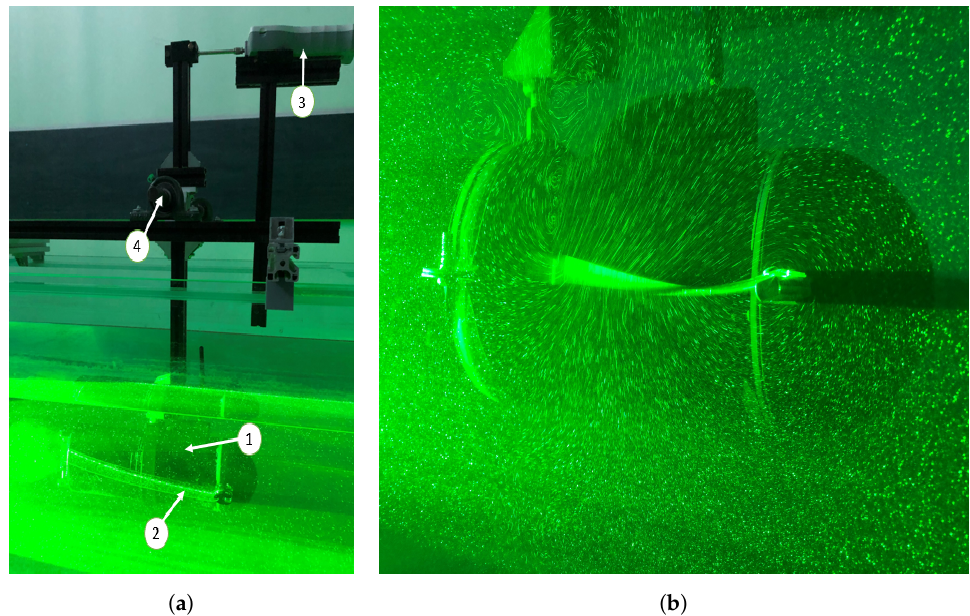
Figure 2. The laboratory water tunnel and green linear laser highlighting one of the side fin ( a ): 1— BUUV, 2—the side fin, 3—the force sensor, and 4—a ball bearing; ( b ) particles illuminated by linear green